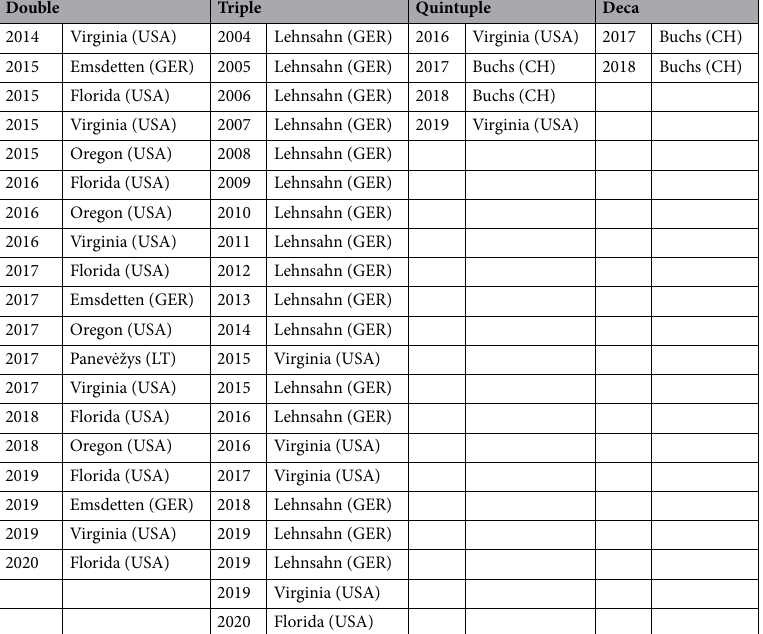
and time per lap for every cycling and running lap. We excluded swimming times for the analysis because no lap times were recorded. However, evidence suggests that variations of pacing during swimming are not apparent 11 . One race had to be excluded because of missing split times (Triple Iron ultra-triathlon in Bad Blumau, Austria). We included only official finishers. Finishers with improbable speed values (i.e., cycling speed > 48 km/h and running speed > 20 km/h) were also excluded. The last races included were the Double and Triple Iron ultra- triathlon in Florida in 2020, as the other races had been canceled due to the COVID-19 pandemic. Statistical analyses. Data normality and homogeneity were confirmed with Kolmogorov–Smirnov and Levene’s test, respectively. Pacing variation was calculated individually as the coefficient of variation (%) between the average speed of each lap in the close circuit the athletes performed their ultra-triathlons. Each cycling lap ranges from 4 to 16.4 km and the running lap ranges from 1.4 to 3.5 km. Total distance is standard for all athletes. The performance level was defined according to the 33.3 and 66.6 percentile of overall race time for women and men. The first percentile (≤ 33.3 percentile) was named as ‘fast’, the last percentile (≥ 66.6 percentile) was named as ‘slow’, and the intermediate was named as ‘moderate’ 26 . A multivariate model with two factors (two-way ANOVA) was applied for race time performance (overall, swimming, cycling, running) as the dependent vari- able with ‘sex’ and ‘age group’ as independent factors. Quintuple and Deca Iron ultra-triathlon were not included in the previous model because of the low number of participants across the age groups. Another multivariate model with two factors with ‘age’ and ‘sex’ as covariates (two-way ANCOVA) was applied with pacing variation (cycling and running) as dependent variable, ‘race’ and ‘performance level’ as independent factors. Partial eta squared (η p2 ) was calculated for the ANOVAs where the values of the effect size 0.01, 0.06, and above 0.14 were considered small, medium, and large, respectively 40 . Statistical significance was defined as p < 0.05. All statistical analyses were carried out with Statistical Software for the Social Sciences (IBM® SPSS v.25, Chicago, Ill, USA).